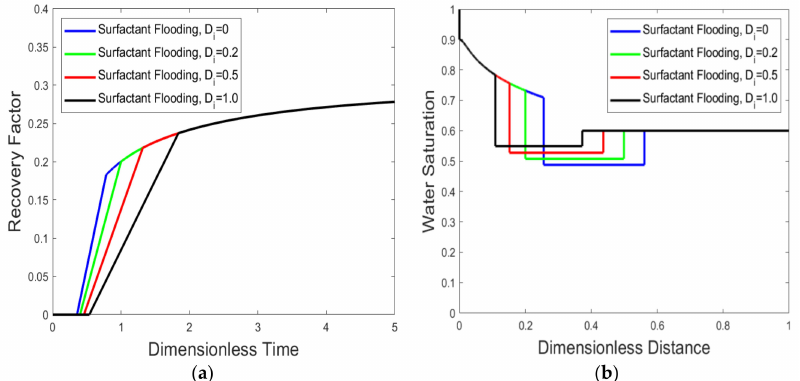
Figure 10. ( a ) Incremental oil recovery by surfactant flooding as a function of retardation factor; and ( b ) saturation profile at t D = 0.2 PV for di ff erent retardation